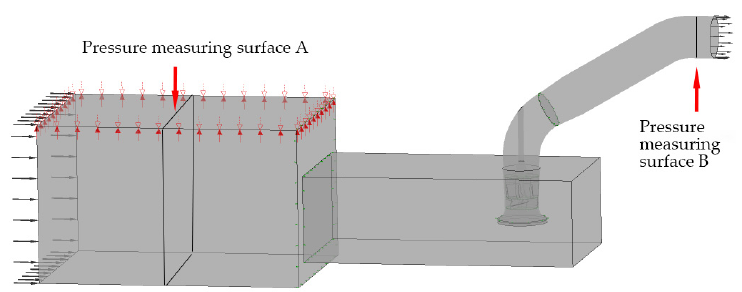
Figure 9. Pressure measuring surface A and B.